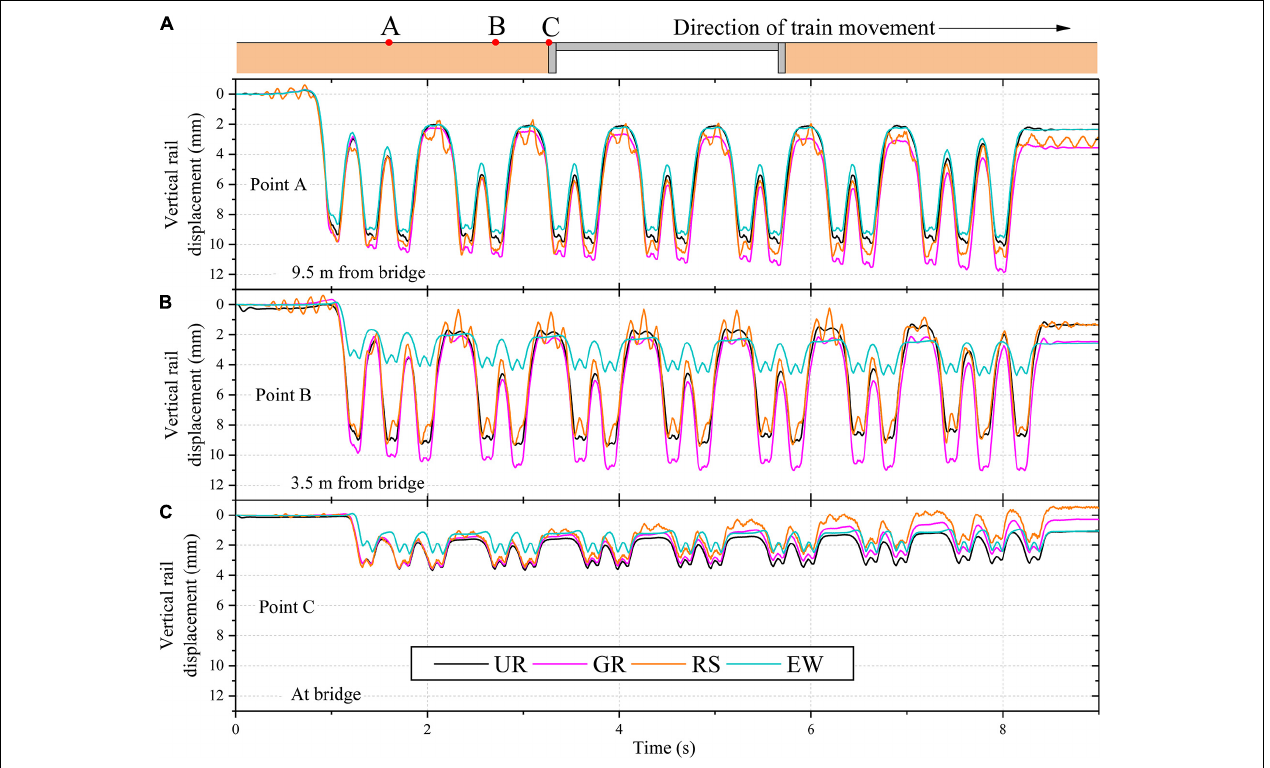
FIGURE 8 | Variation of vertical rail displacement with time for critical zones with and without mitigation measures at: (A) 9.5 m from the bridge; (B) 3.5 m from the bridge; (C) the